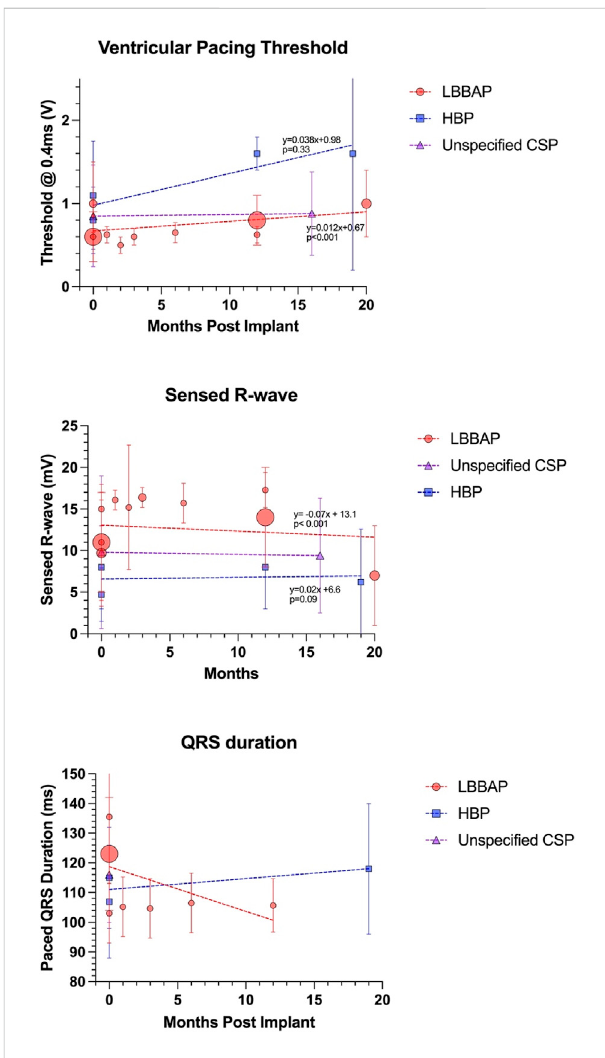
Table 1. Size of data point is proportional to number of subjects. Regression equations and p -values reported for LBBAP and HBP only (note that Cano et al. did not separate HSP versus LBBAP lead